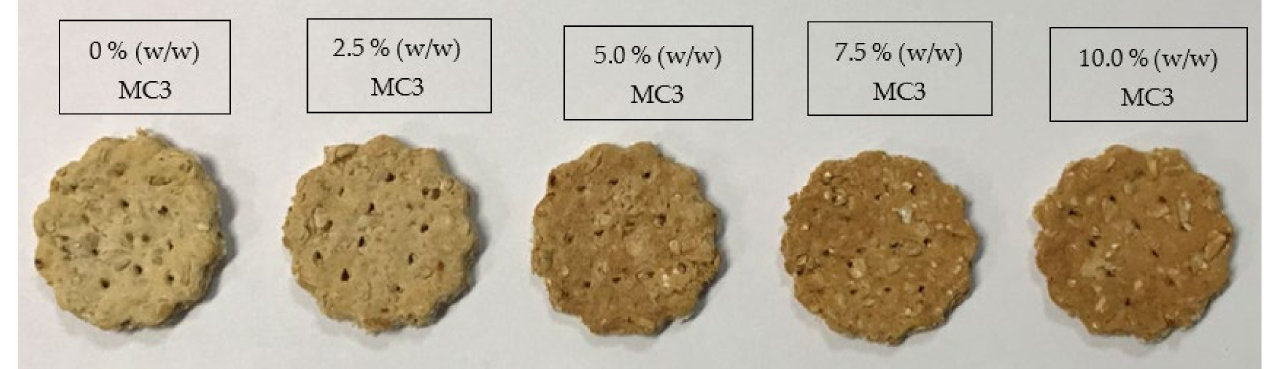
Figure 5. Whole wheat crackers fortified with MC3 at different levels. MC3: spray-dried microcap- sules containing 3% MBPI, 0.3% SA, and 0.5% ( w / w ) SO-TSO.